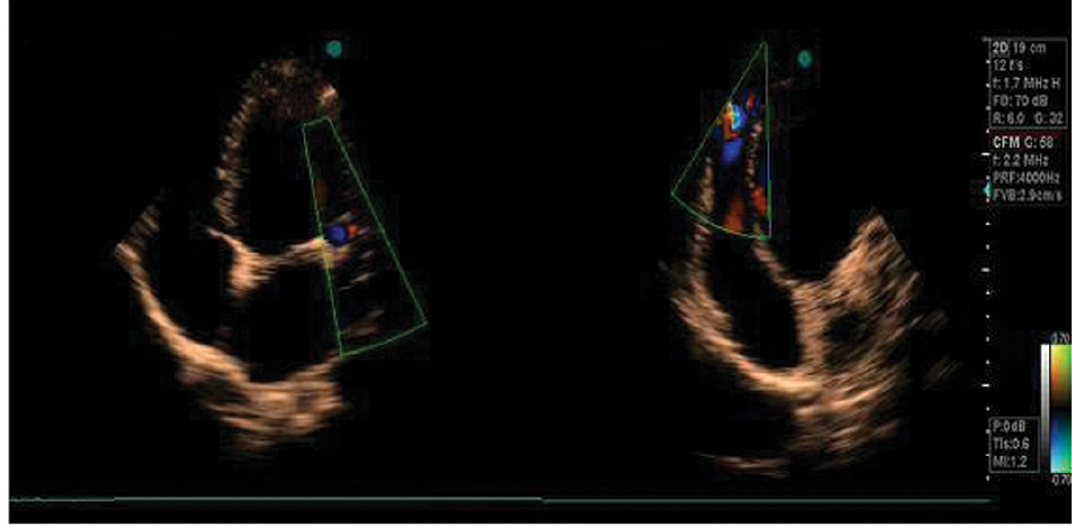
Figure 1 - A transthoracic echocardiogram showing the markedly dilated left coronary artery (left) and an abnormal flow to the right ventricle, suggesting the diagnosis of a coronary fistula to a right cardiac chamber (right).